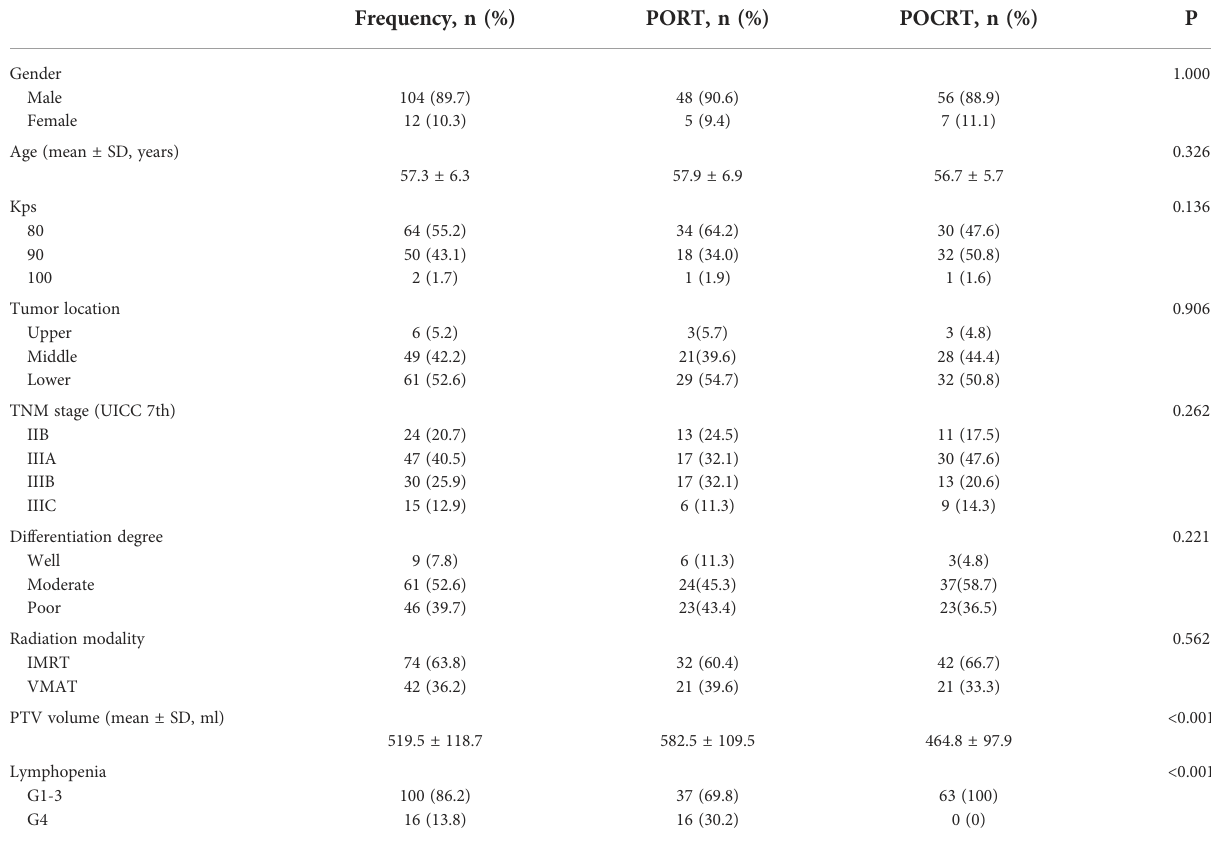
TABLE 1 Comparison of patient characteristics between PORT and